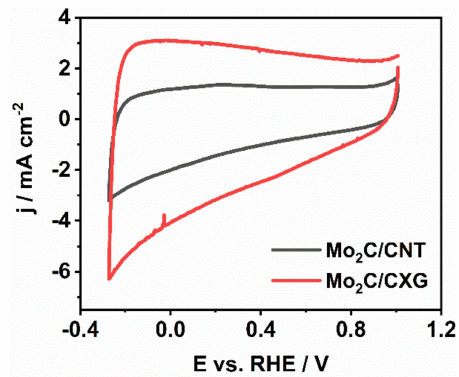
Figure 4. Cyclic voltammograms of Mo 2 C / CXG and Mo 2 C / CNT recorded in 6 M KOH at the scan rate of 50 mV s − 1